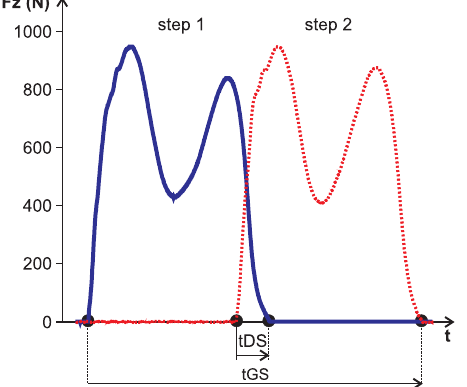
Figure 2. Vertical components of the GRF of two steps and measured variables. tDS = double support duration, tGS = duration of gait stride: from the initial contact of one leg to the toe off of the other leg (In- man, Ralston, & Todd,